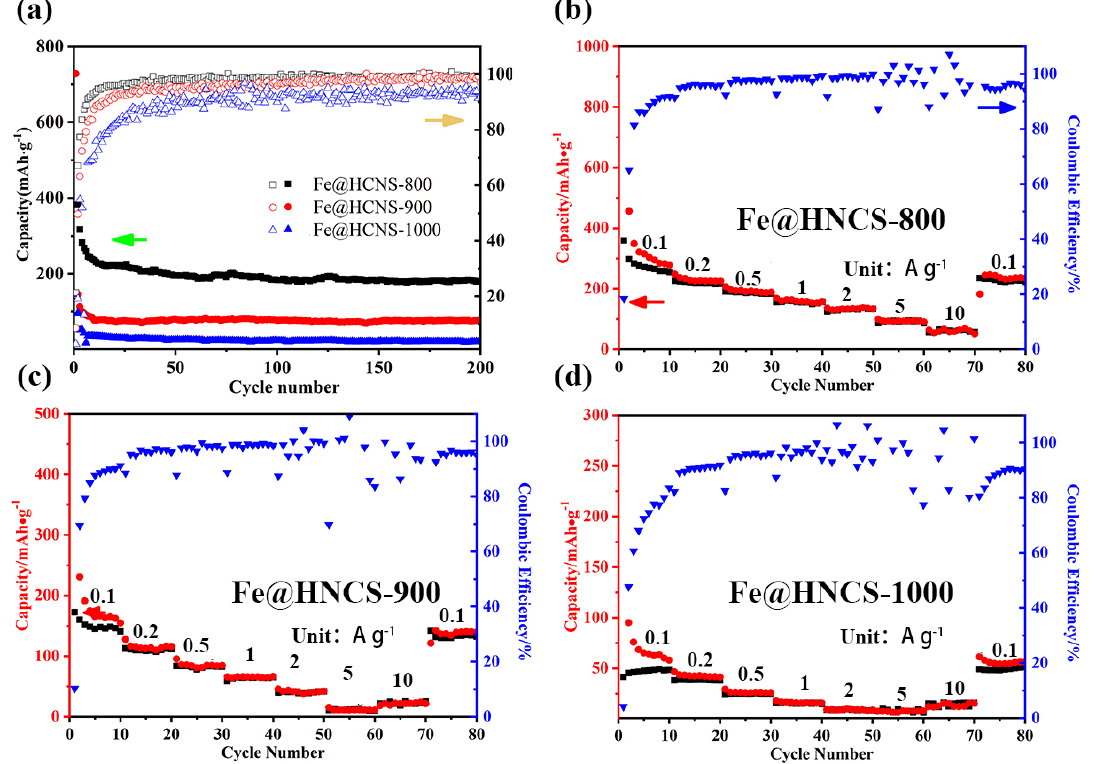
Figure 5. ( a ) Cyclic performance of Fe@HNCS-800, Fe@HNCS-900, and Fe@HNCS-1000; ( b